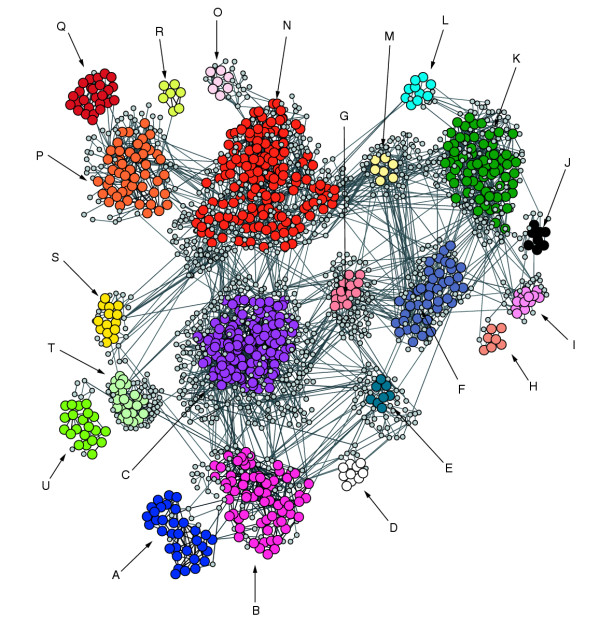
Simplification of the yeast FOCI coexpression network constructed by retaining the 4,000 strongest edges (= 1,729 vertices). The colored vertices represent a subset of the locally distinct subgraphs of the FOCI network; letters are as in Table 2, and further details can be found there. Some of the locally distinct subgraphs of Table 2 are not represented in this figure because they involve subgraphs whose edge weights are not in the top 4,000 edges.